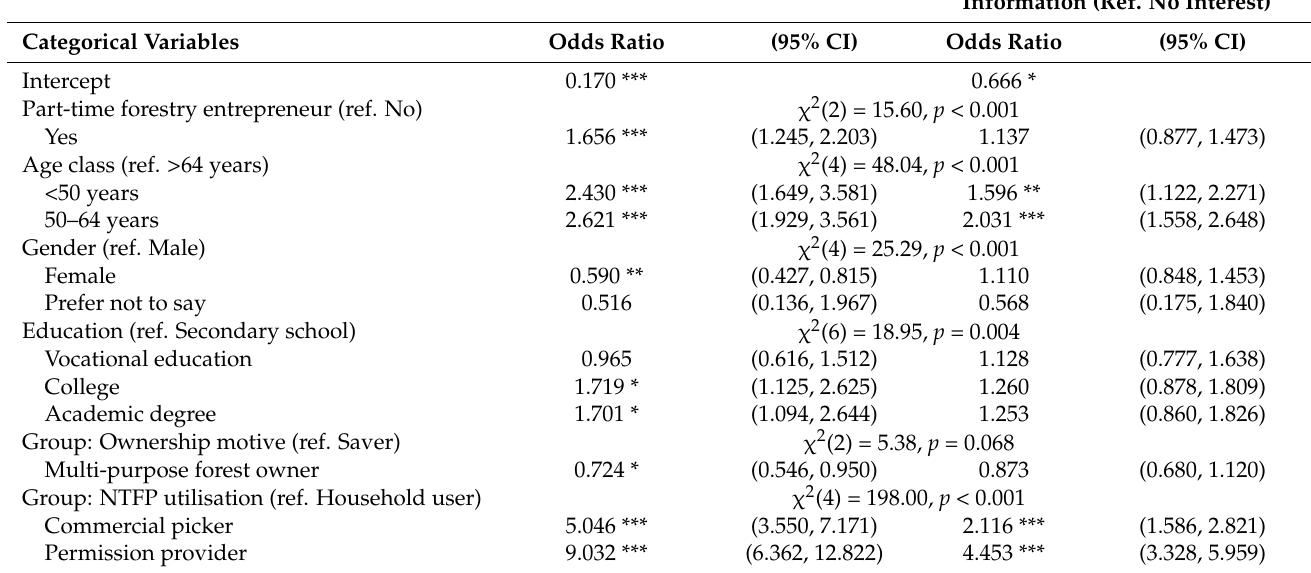
Table 11. Multinomial logistic model (odds ratios and 95% CI) on the probability that forest owners had an interest in cultivating specialty mushrooms on stumps in their forests (n = 591), or could not say, or needed more information (n = 969). The reference category is the forest owners who were not interested (n = 458). χ 2 is the joined Wald χ 2 test of the categorical effects, the degree of freedom in parentheses.